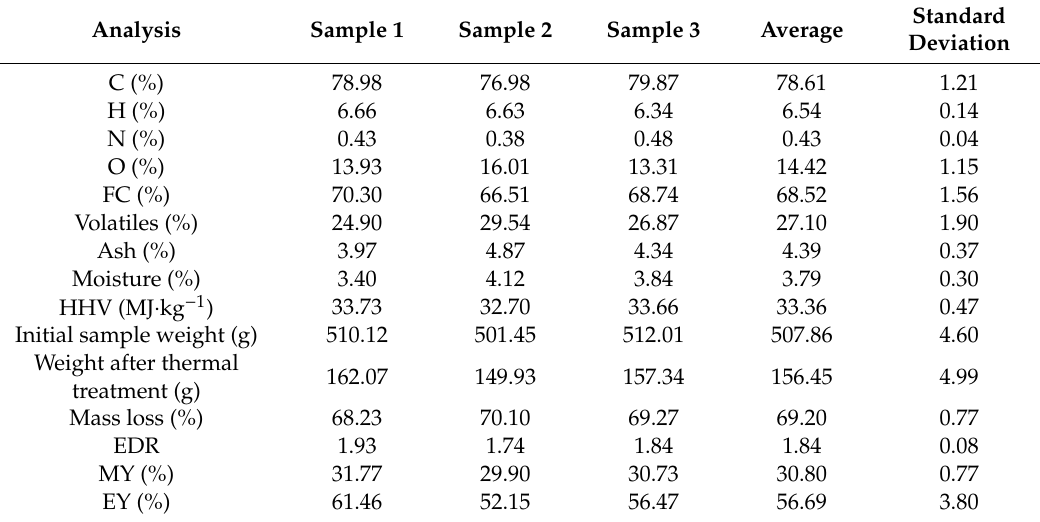
Table 6. Results obtained in analysis of samples thermally treated at 300 ◦